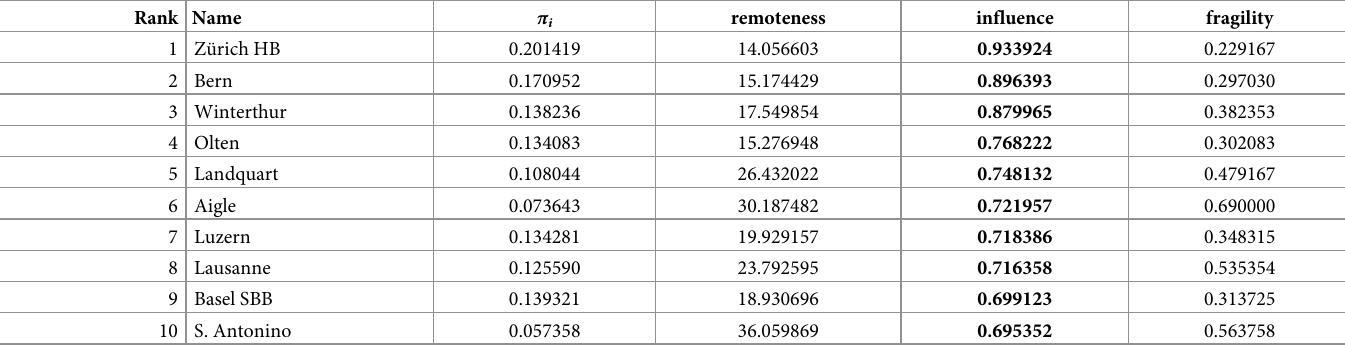
Table 2. Top ten most influential stations, 1 month median.